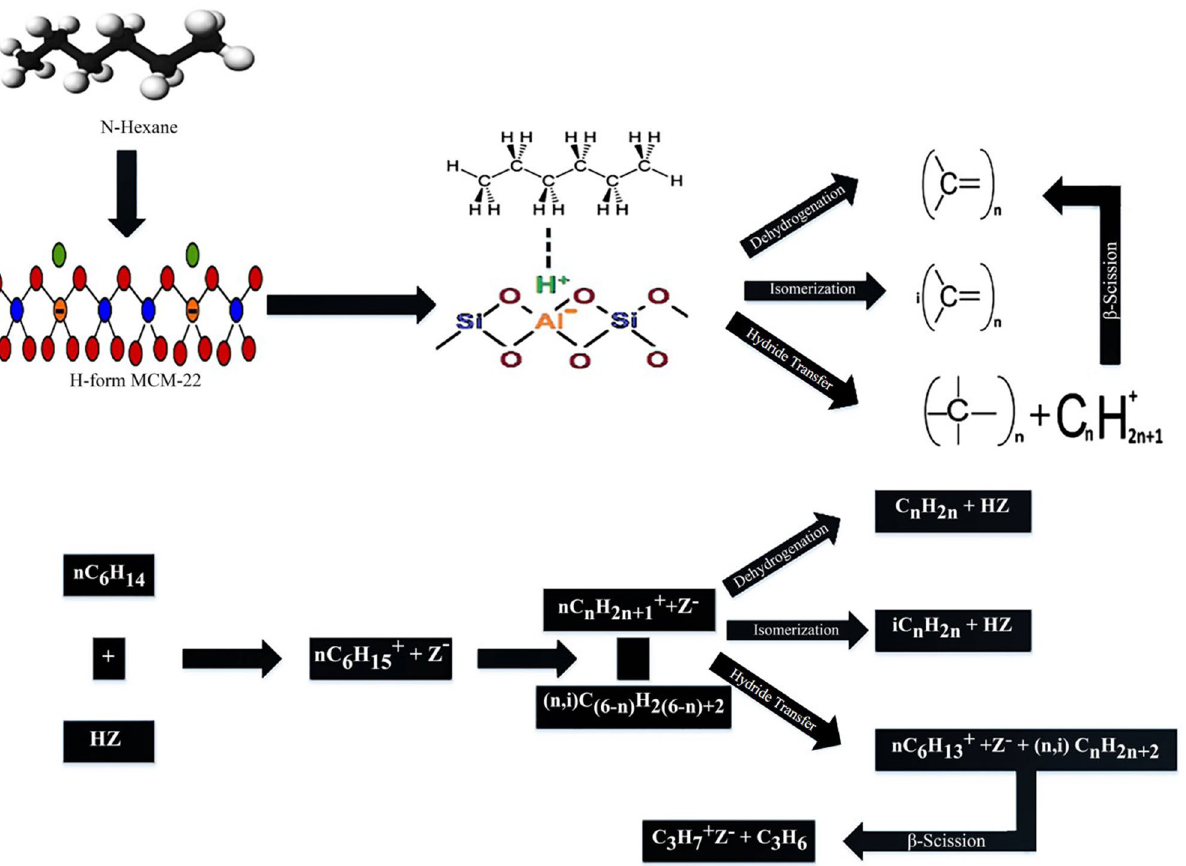
Figure 9. Reaction mechanism for n-hexane cracking over acidic